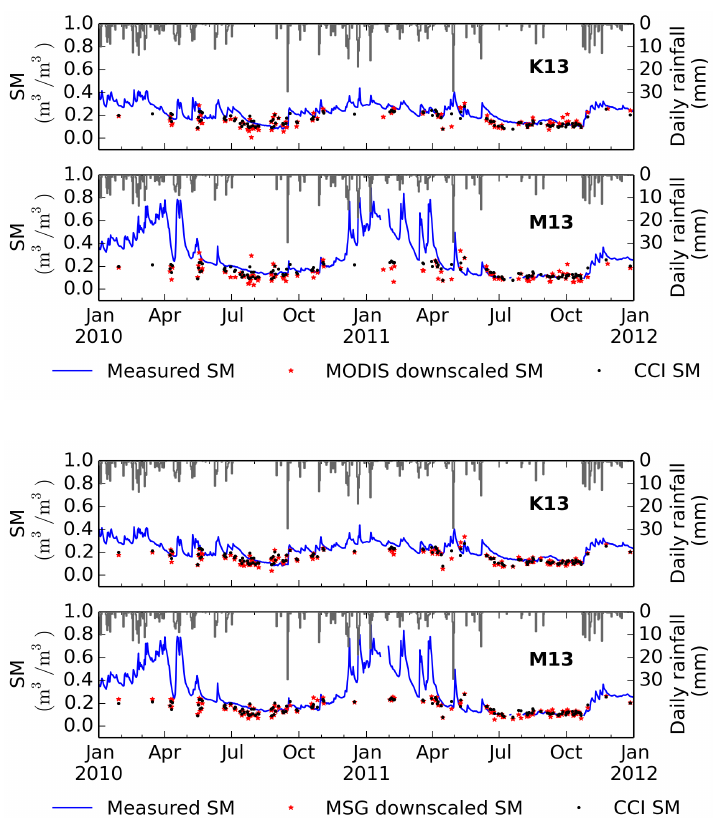
Figure 7. Time series of the in situ soil moisture, CCI soil moisture, downscaled CCI soil moisture, as well as rainfall for stations K13 and M13. The results from MODIS and SEVIRI are shown